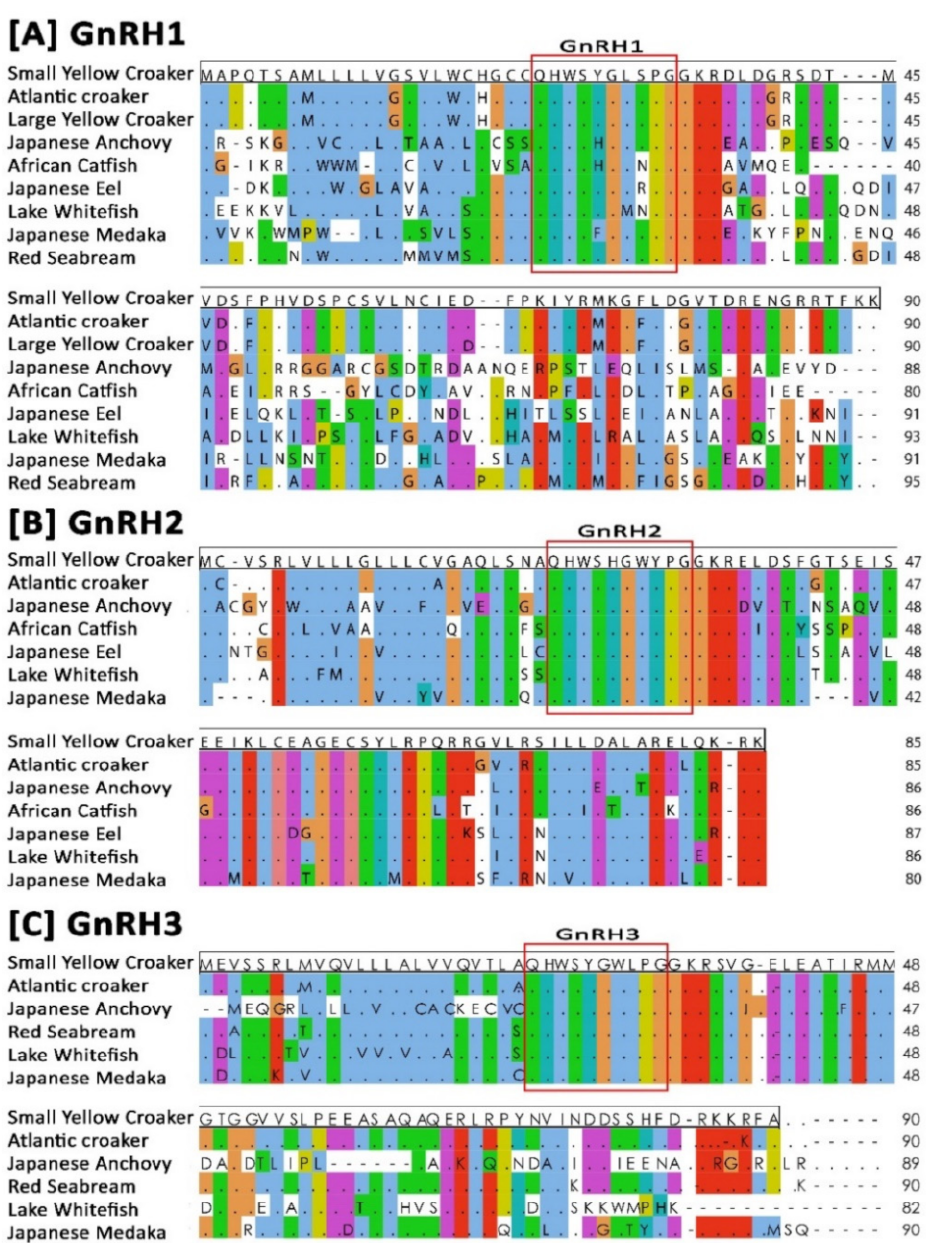
Figure 2. Multiple sequence alignment of deduced amino acid sequences of GnRH1 ( A ), GnRH2 ( B ), and GnRH3 ( C ). Identical amino acids are indicated by dots. Dashes indicate gaps. Corresponding amino acid sequences of GnRH decapeptides are marked in a red box. GenBank accession numbers of each GnRH isoforms are presented in Supplementary Table